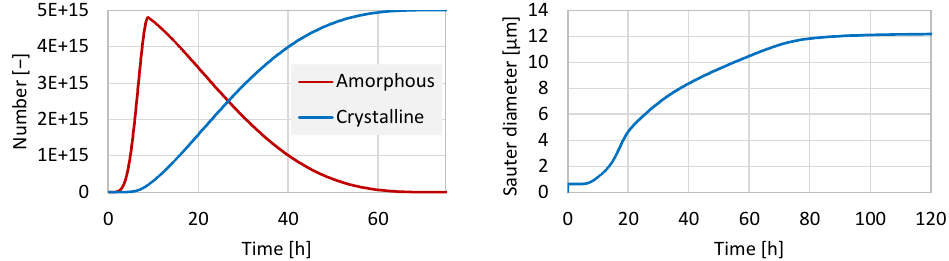
Figure 10. Change in the number of X-ray amorphous and crystalline particles ( left ), and in the Sauter mean diameter of agglomerating particles ( left ) during the synthesis.